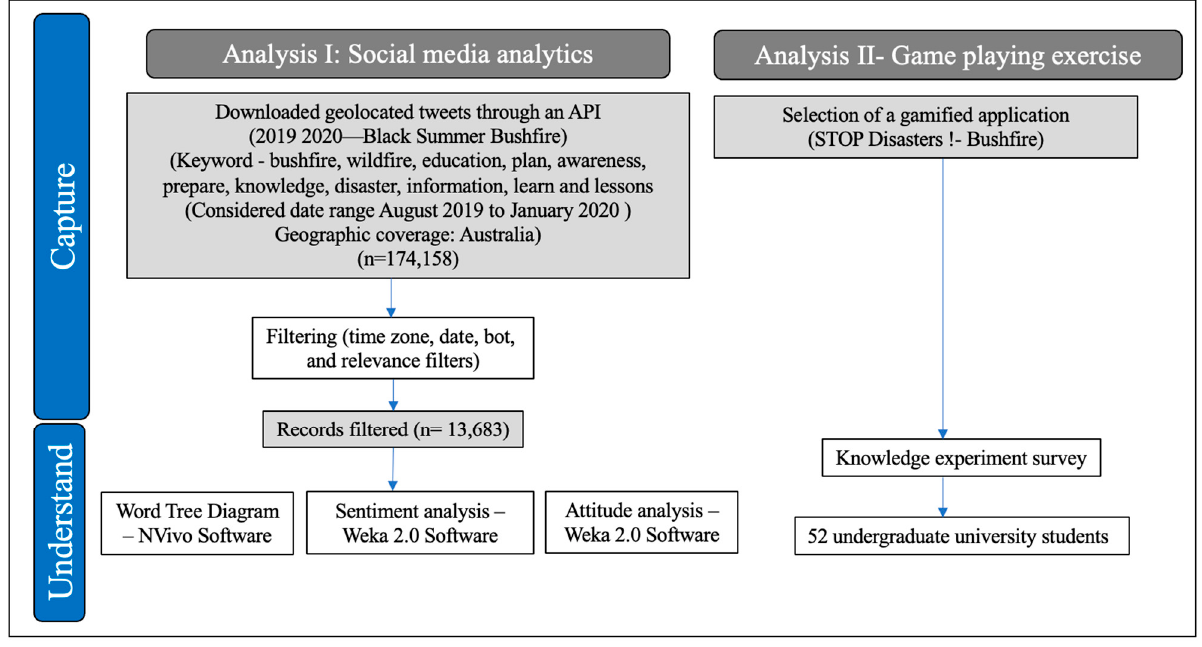
Figure 2. Overall methodological